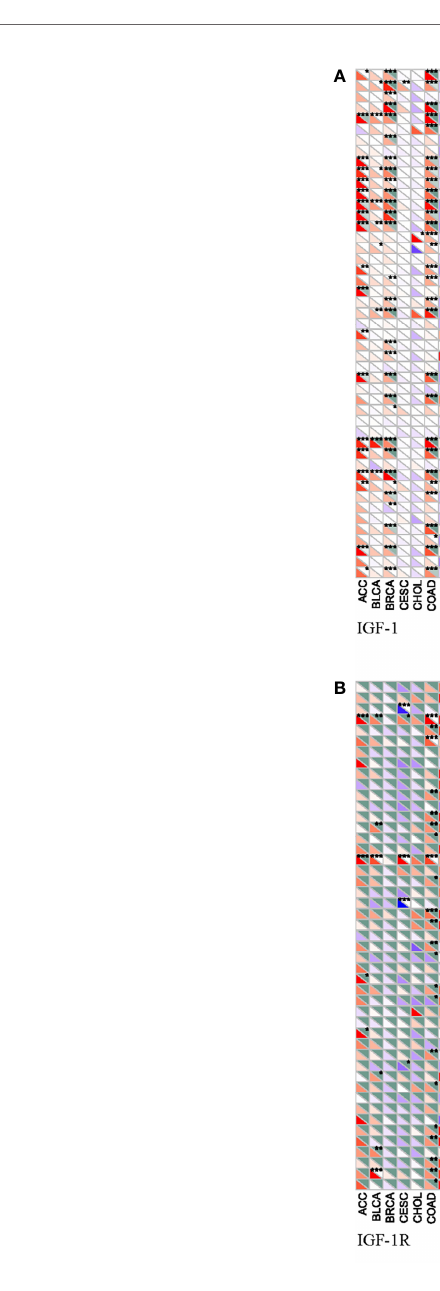
FIGURE 6 | Correlation of IGF-1 (A) and IGF-1R (B) expressions with expression of immune checkpoint genes across 33 cancer types. “ *, **, *** ” means signi fi cant correlation p < 0.05, p < 0.01 and p < 0.001,